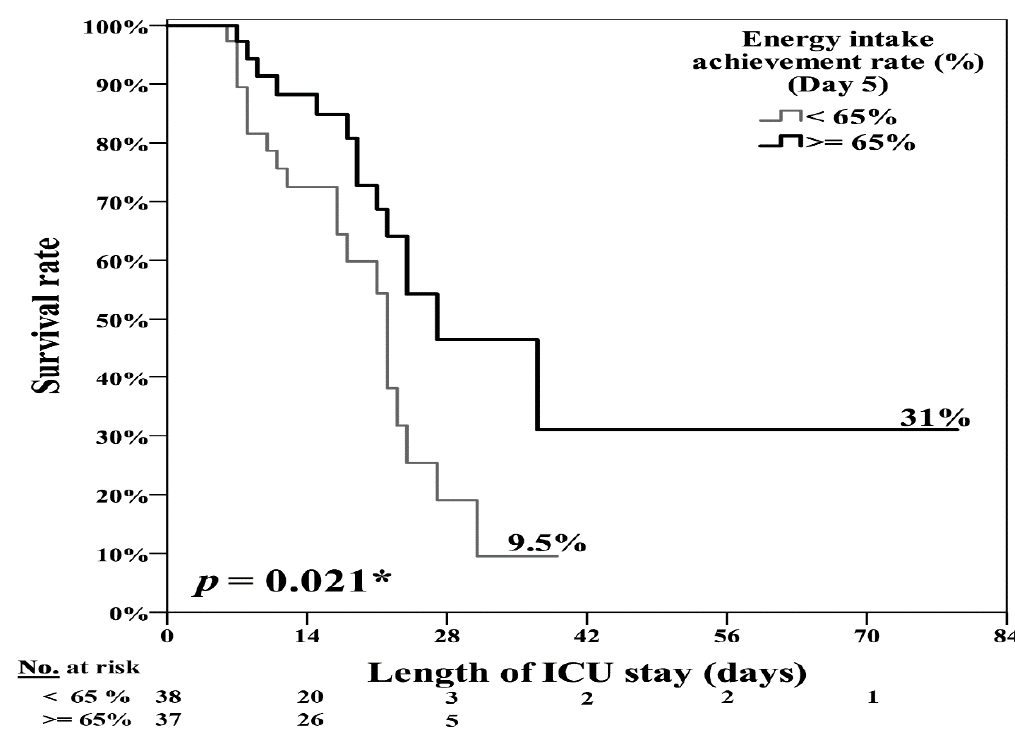
Figure 3. Hazard ratio (HR) of ICU mortality of critically ill patients with high nutritional risk and moderate to severe ARDS receiving prolong prone positioning (PP) therapy. mNUTRIC score: mod- ified nutrition risk in the critically ill score.